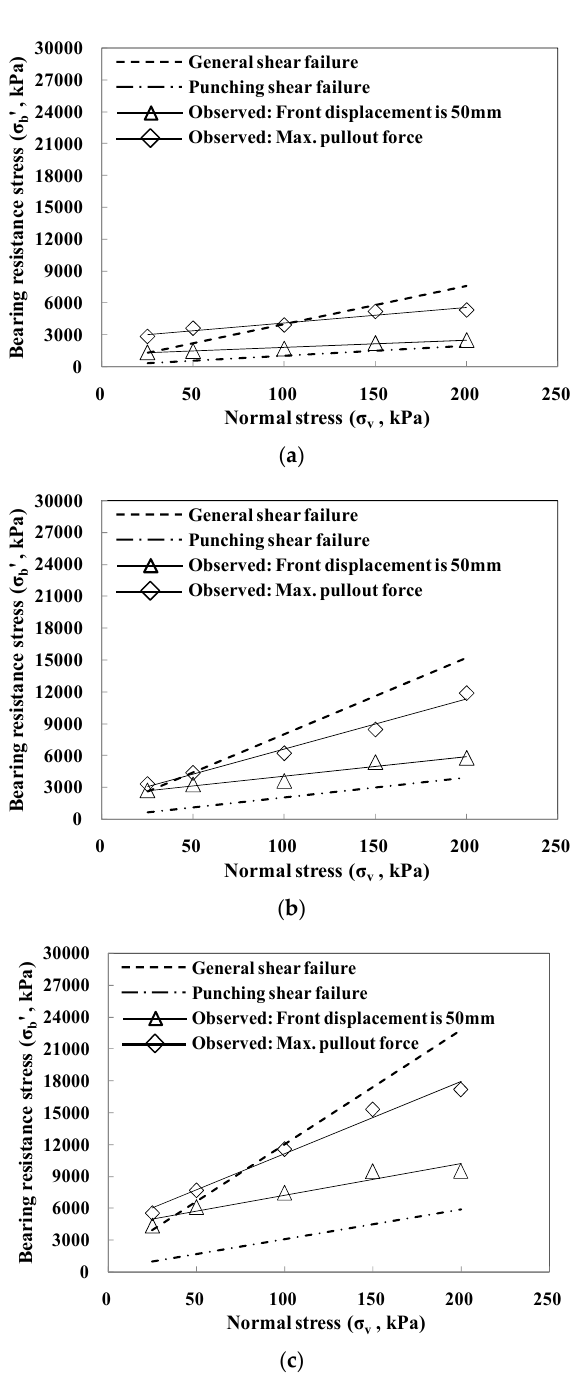
Figure 7. Comparison of predicted and observed bearing-resistance stress according to number of transverse members: ( a ) PS1-1, ( b ) PS2-1, and ( c ) PS3. Bearing-resistance stress in all cases, which had applied pullout force at 50 mm front displacement, was close to the general shear failure in the lower normal stress condition.